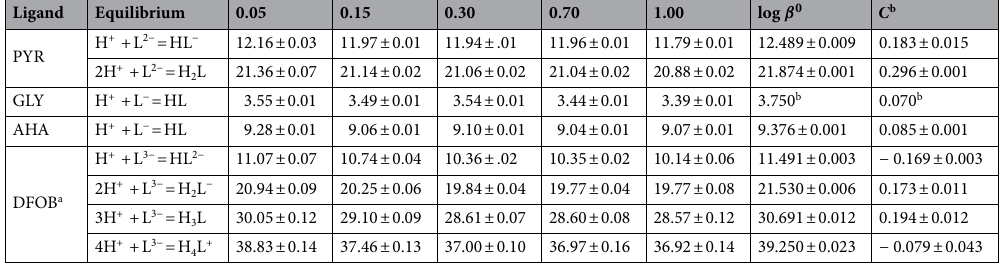
Table 1. Ligand protonation constants (log β ) at different [NaCl] (M) and T = 298.1 K. a 30. b Error < 0.001 and therefore not